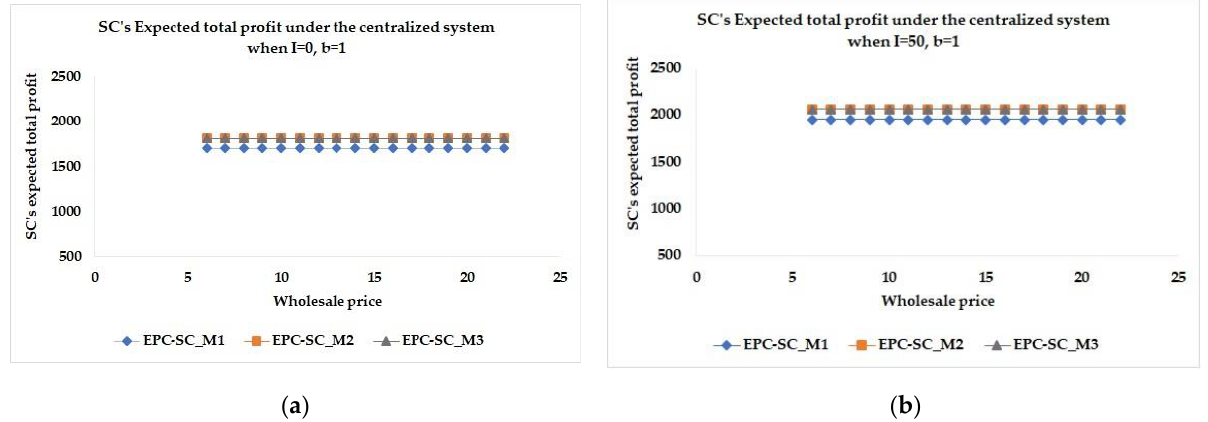
Figure 5. The supply chain’s expected total profits of Model 1, Model 2, and Model 3 under the centralized system with different values of w , where b = 1 and ( a ) I 0 = 0; ( b ) I 0 =